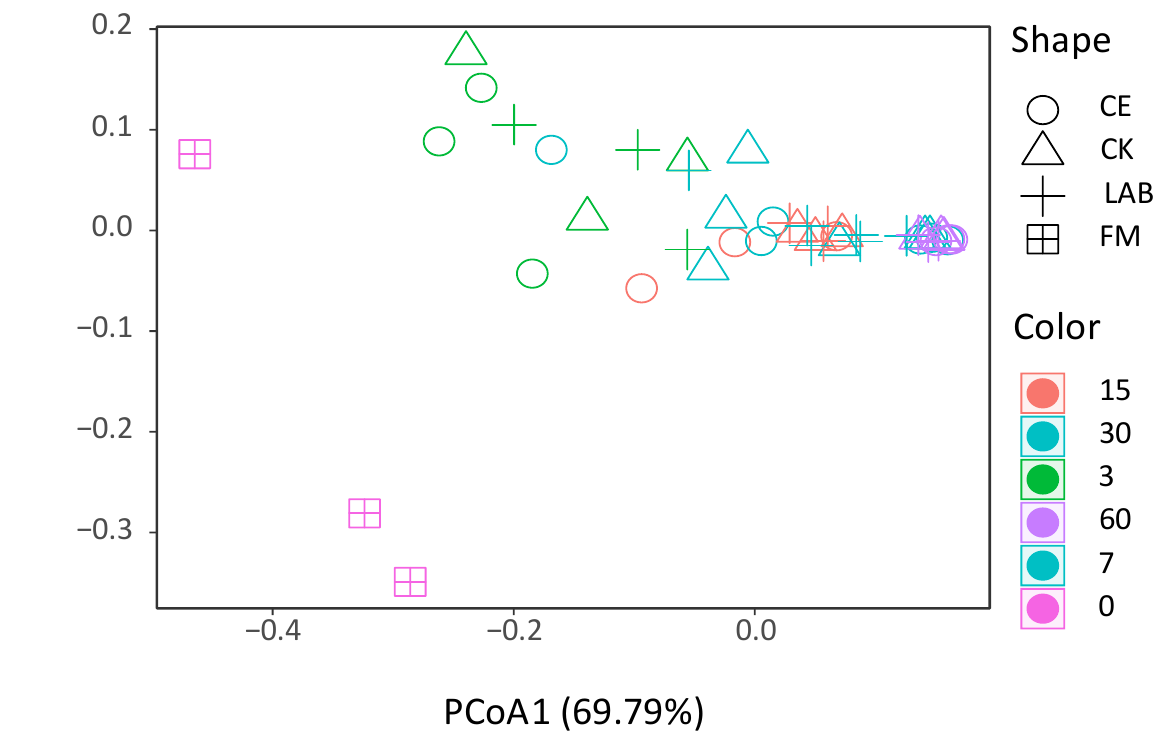
Figure 1. The community dissimilarities in different additives treatments and fermentation time, calculated via weighted UniFrac distances, with coordinates calculated using principal coordinates analysis (PCoA). FM, fresh material; CK, no additive control; CE, cellulase; LAB, lactic acid bacteria. As shown in Figure 3, the linear discriminant analysis effect size (LEfSe) was applied to evaluate the difference in microbial community among the three groups at different silage times (LDA score > 3.0). We focused on the differences among the three groups at the genus level. After 3 days of ensiling, the Lactiplantibacillus was higher in the LAB group, while Bacillus and Serratia were higher in CE group, and Arsenophonus was higher in CK group. After 7 days of ensiling, Sphingomonas was higher in CE group. After 15, 30 and 60 days of silage, the main differential microorganisms were only present in the CK and LAB groups. Curtobacterium , Eggerthella , Catonella , Weissella , and Pediococcus were higher in CK group. Nevskia and Flavonifractor were higher in LAB